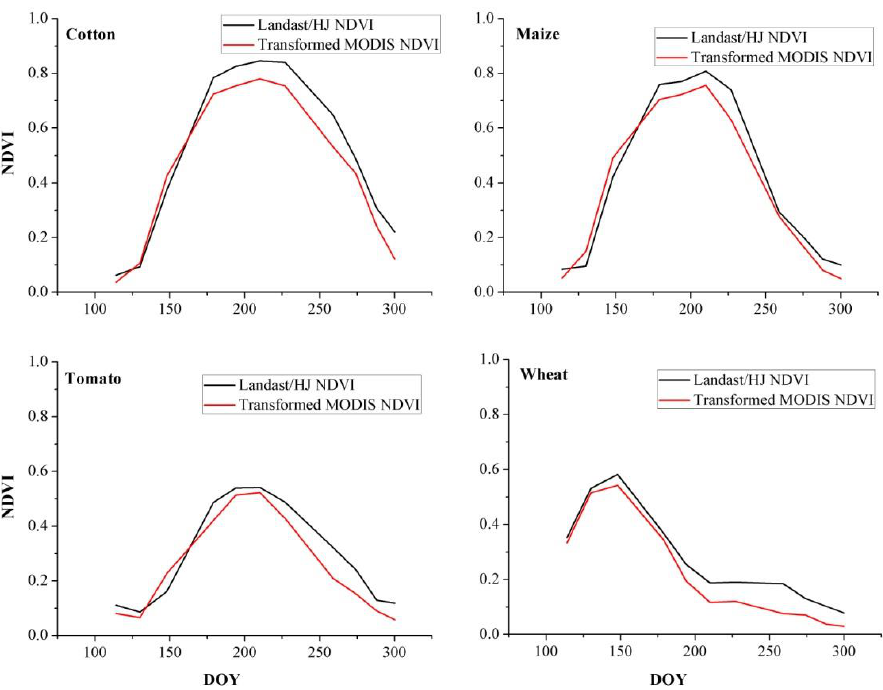
Figure 12. Transformed MODISNDVI and Landsat/HJ NDVI time series in Manas.